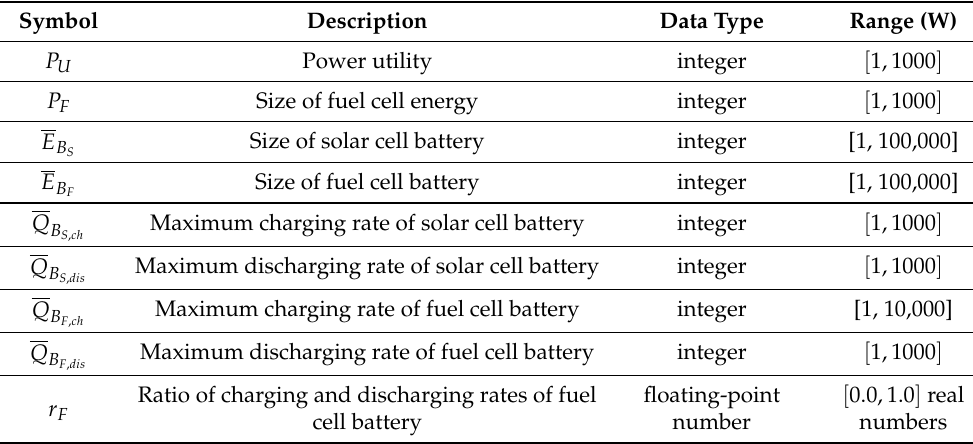
Table 1. List of optimization